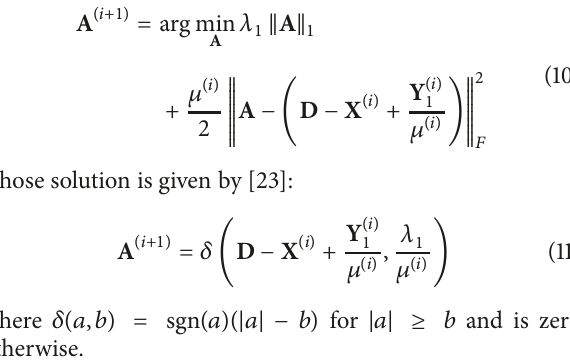
Algorithm 1: Solving for the improved